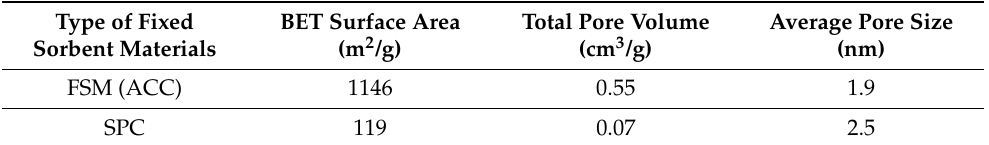
Figure 9. BET adsorption–desorption isotherms for FSM ( A ) and SPC ( B ) fixed sorbent materials. Table 1. The specific surface area and the total volume and size of pores determined by the BET method of fixed sorbent materials (FSM (ACC) and